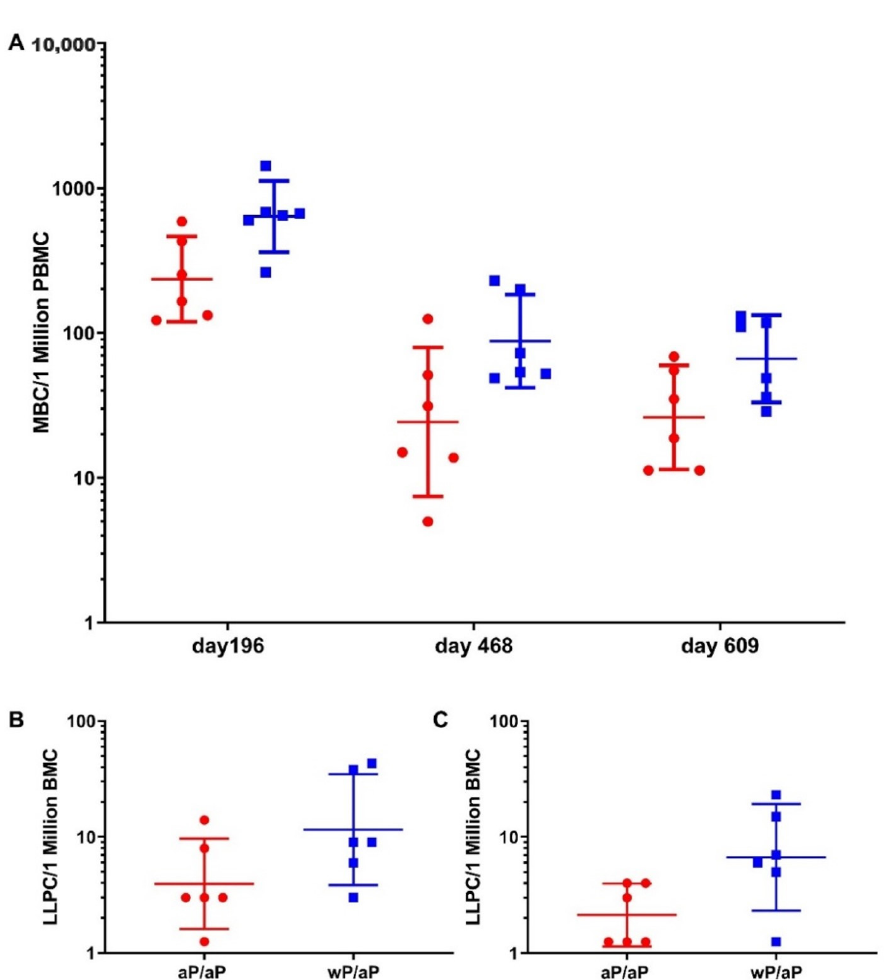
Figure 4. Compared with aP vaccine, priming with wP vaccine leads to an increased B cell response. The circulating memory B cell population ( A ) was assessed using ELISPOT plates coated with a pool of pertussis vaccine antigens (pertussis toxoid, FHA, PRN, and Fim2 / 3). Time of PBMC collection is indicated along the x-axis. ELISPOT plates coated with either a pool of pertussis vaccine antigens ( B ) or HKBp ( C ) were used to assess the antigen specific bone marrow localized long lived plasma cell population in samples collected on study day 609. Animals that were aP vaccine primed and aP vaccine boosted are represented by red circles while animals that were wP vaccine primed and aP vaccine boosted are represented by blue squares. The data points are values from individual animals with the geometric means and 95% CI noted with the corresponding lines. The memory B cell data were analyzed using an ANCOVA model with group as the fixed factor and time as the covariate. A repeated day option was used to consider the identical baboons by day / group. A global p value for the circulating memory B cells was calculated for days 196, 468, and 609 ( p = 0.024). For the long-lived plasma populations, statistical analysis was performed using an ANOVA model with the aP vaccine primed and aP vaccine boosted and wP vaccine primed and aP vaccine boosted animals at day 609 as the fixed factor. While the di ff erence between the pertussis vaccine antigen specific populations was not statistically significant ( p = 0.094) the di ff erence between the HKBp specific populations was statistically significant ( p =